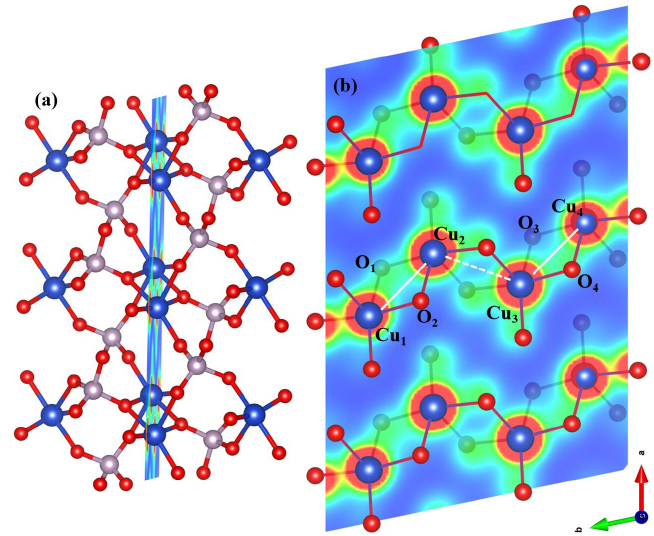
Figure 4. ( a ) Atomic structure of α -Cu 2 P 2 O 7 for AFM-2 state in the (0, 1, 29.5) cross-section plane chosen for charge density calculation. ( b ) Contour plot of the charge density calculated in the (0, 1, 29.5) cross-section plane within HSE density functional. The isosurface level of the charge density is set at 0.3 e /Å 3 ; the image is produced using VESTA [62]. The white solid and dotted lines indicate, respectively, the distances of 3.056 Å for d Cu bond and 3.266 Å for d Cu bond. 2 − Cu 3 1 − Cu 2